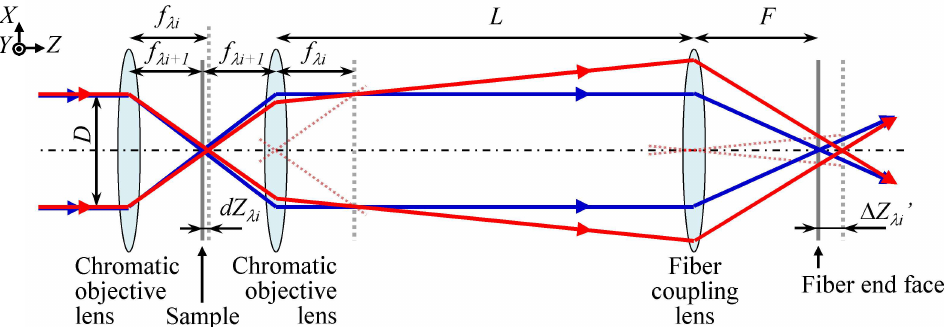
Figure 8. Schematic of the optical setup in the chromatic confocal probe.